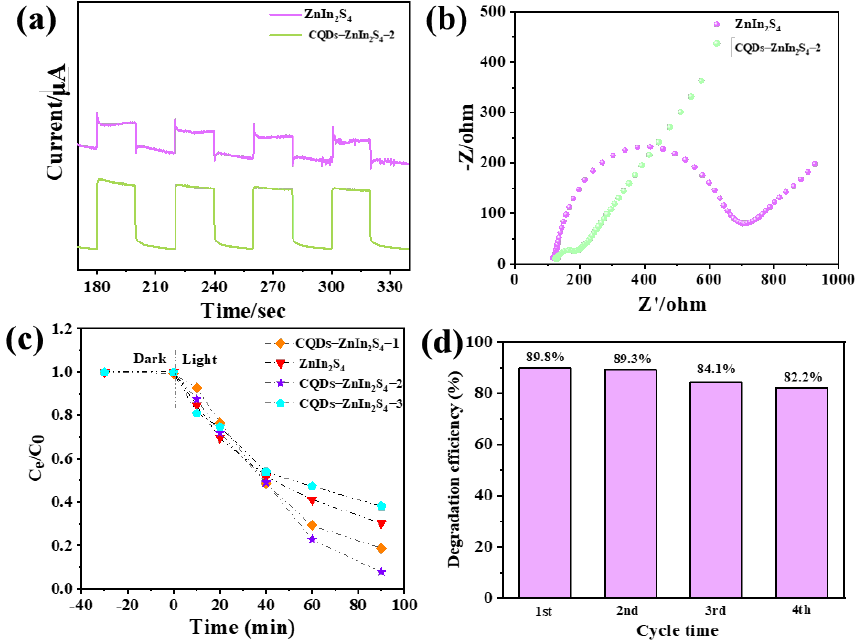
Figure 3. ( a ) Transient photocurrent spectra; ( b ) EIS spectra of the as-prepared samples; ( c ) photocatalytic performance of 4-CP degradation on different photocatalysts; and ( d ) cycling experiments of photocatalytic activity evaluation on CQDs/ZnIn 2 S 4 -2.